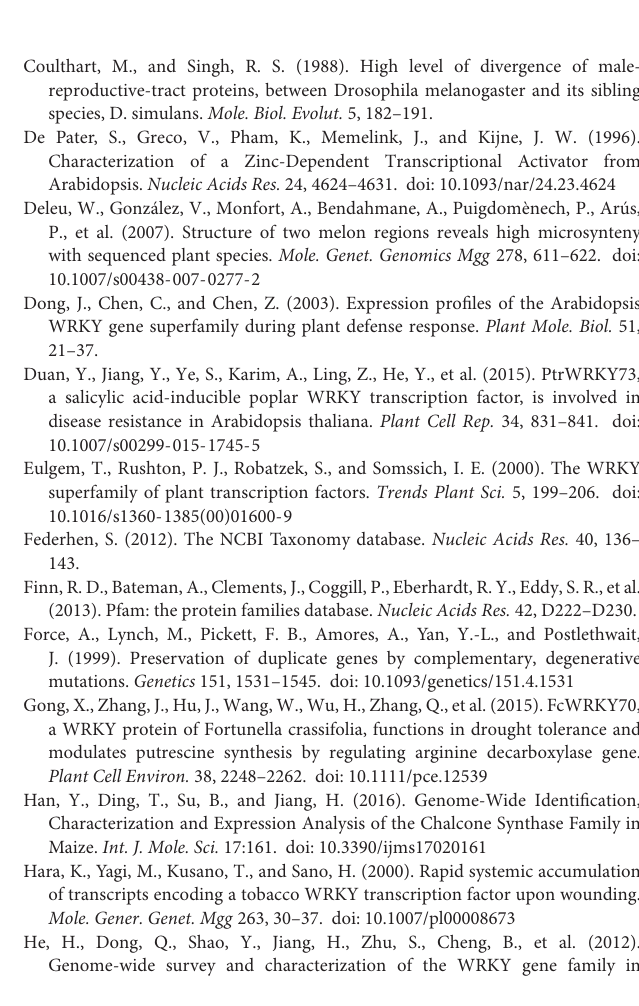
Supplementary Figure 5 | Expression profiles of P. avium WRKY I genes in different tissues. Blue and red colors correspond to downregulation and upregulation, respectively.